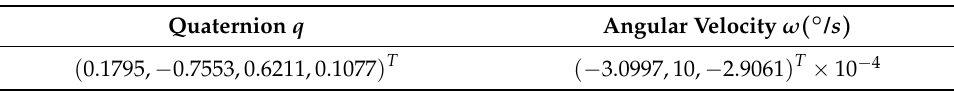
Table 4. Initial